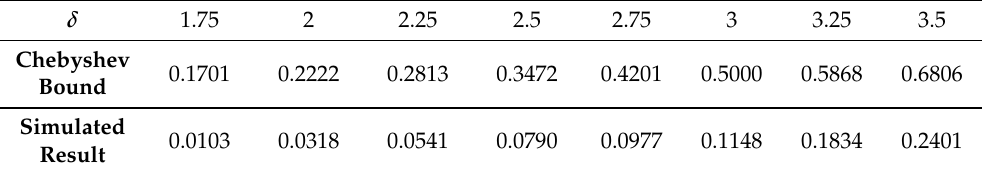
Table 3. Values for the standard uniform